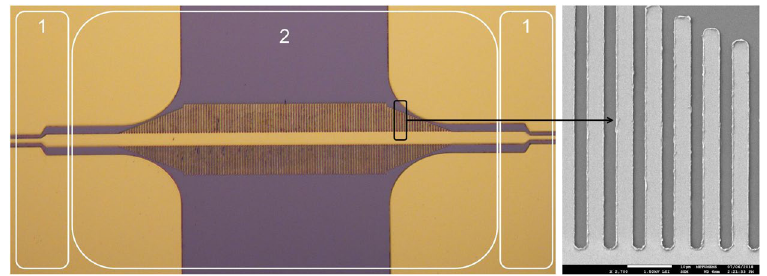
Figure 2. The microscope and SEM images of one of the fabricated sSPP WG (Set 1, h = 57.5 μ m). CPW connections between the contactless probes and original devices (1) and original device